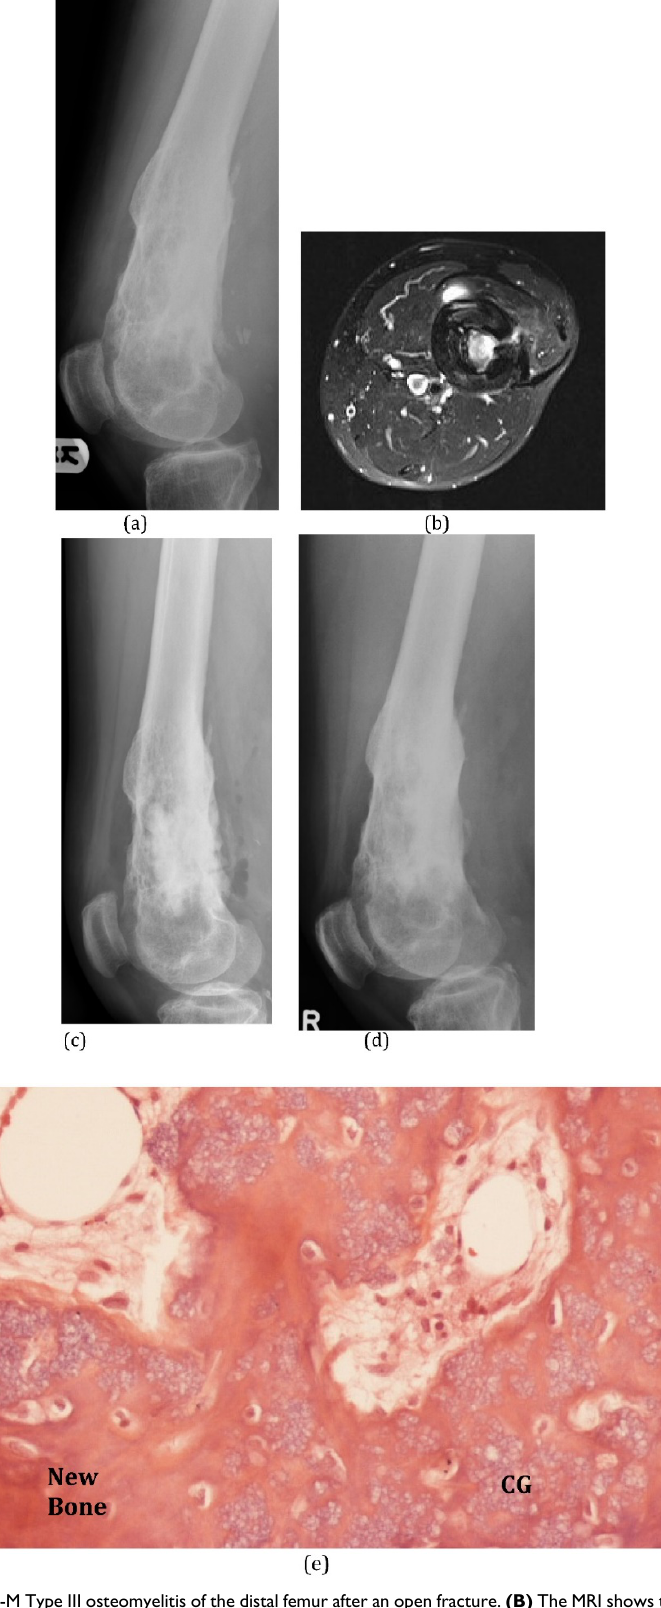
Figure 5. (A) This patient suffered C-M Type III osteomyelitis of the distal femur after an open fracture. (B) The MRI shows the extensive medullary sequestration, the lateral cortical opening (cloaca) and anterior abscess. (C) At operation, the infected bone was excised and the cavitary defect filled with 30mls of calcium sulphate/hydroxyapatite biocomposite with gentamicin (Cerament™G). (D) Six months after implantation, the biocomposite has undergone major remodeling. (E) Bone biopsy (Haematoxylin and Eosin stained microscopy) shows widespread new bone formation within and on the surface of the material (CG = Cerament